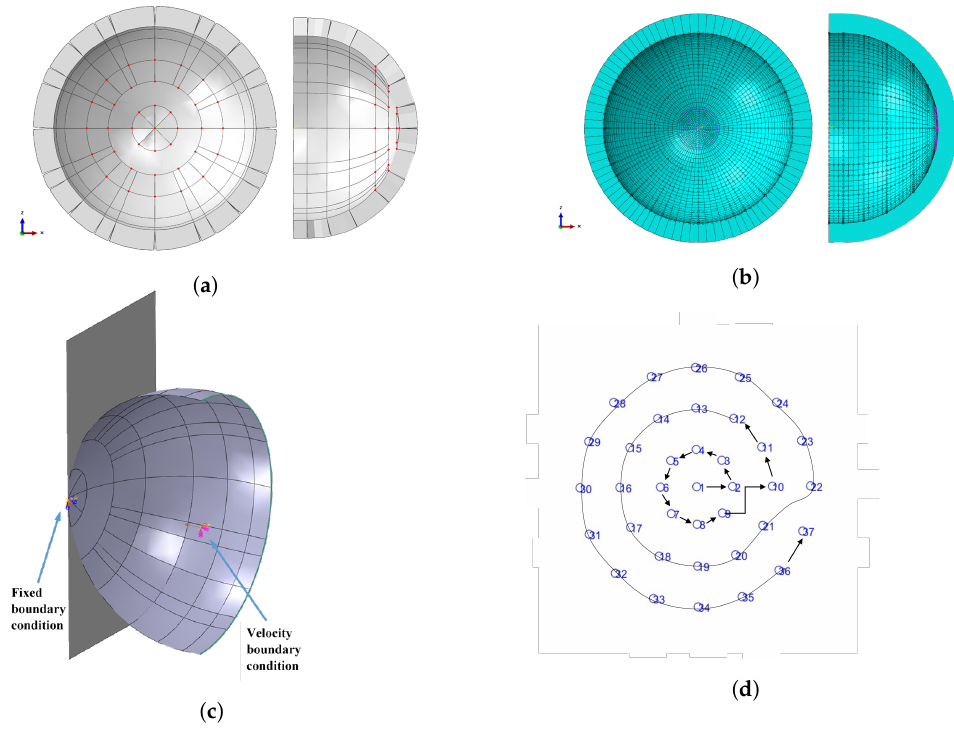
Figure 7. ( a ) Model markers; ( b ) model meshing; ( c ) model boundary conditions; ( d ) markers’